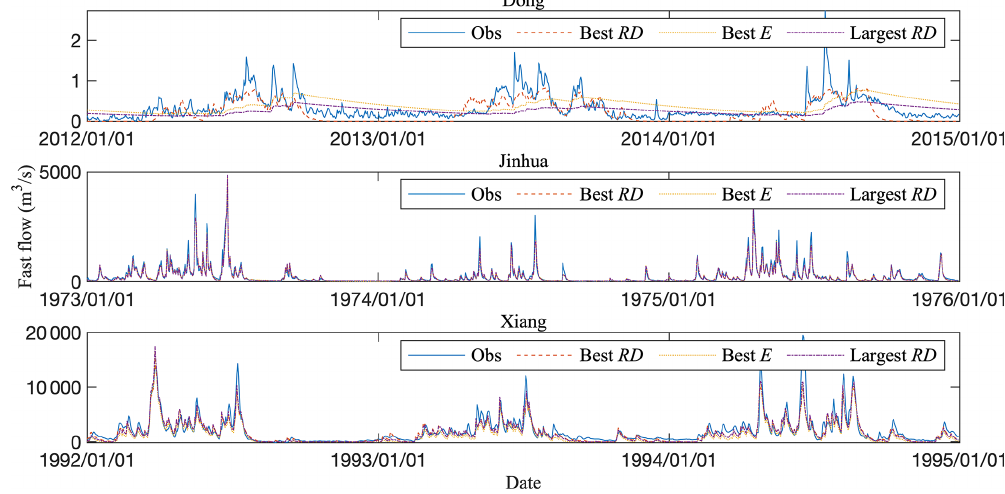
Figure 14. Fast flow in typical models and observations (representative 3 year hydrographs are